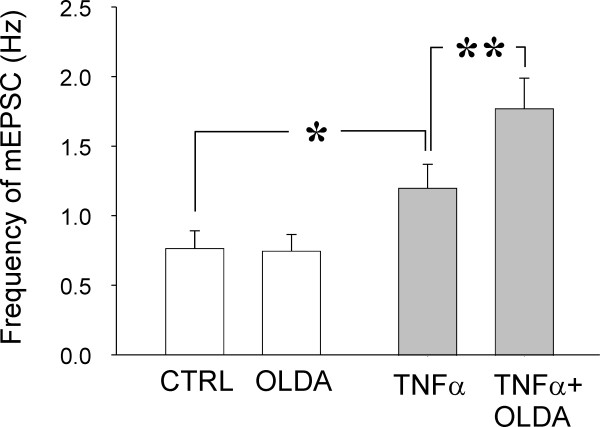
In control slices without TNFα pretreatment, OLDA application did not induce a significant change in mEPSC frequency. Incubation with the cytokine TNFα increased basal mEPSC frequency (n = 10; *P < 0.05) in a population of DH neurons with capsaicin-sensitive primary afferent fibre inputs, when compared to recordings from control slices without TNFα incubation (n = 25). The high statistical significance of the mEPSC frequency increase during OLDA application in neurons after TNFα incubation was also evident without data normalization (**P < 0.01).